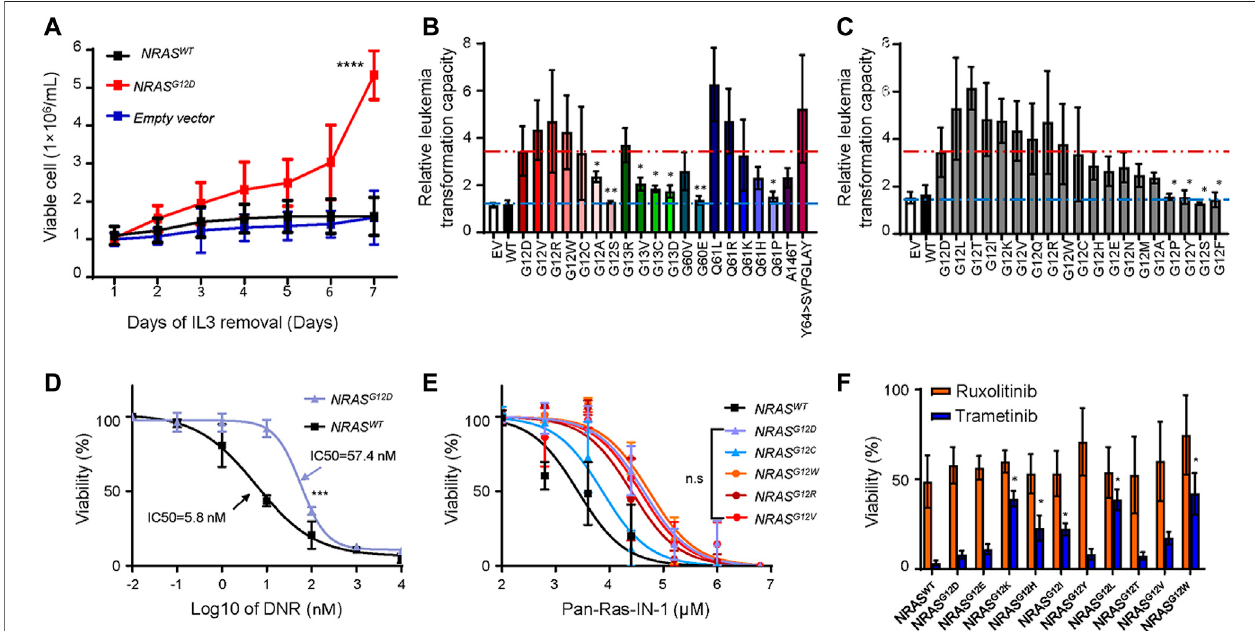
FIGURE 2 | Transforming potentials and drug response of NRAS mutation s in Ba/F3 cell line. (A) IL-3 independent cell growth of Ba/F3 cells transduced with NRAS G12D , NRAS WT and empty vector. (B – C) Relative leukemogenic capacity betweenreportedNRAS mutations (B) and G12saturated mutant forms (C) . Differences were calculated between NRAS G12D and other NRAS mutants by student t test. Dark red dash line represents the NRAS G12D transforming capacity as positive control, and light blue dash line represents non-transforming capacity. The relative capacity was calculated by the ratio of viable cells between day7 and day1. Cytotoxicity of DNR (D) , Pan-Ras-IN-1 (E) , trametinib and ruxolotinib (F) were examined in Ba/F3 cells with NRAS mutations (black line, NRAS WT ; purple line, NRAS G12D ; blue line, NRAS G12C ; orange line, NRAS G12w ; brown line, NRAS G12R ; red line, NRAS G12V ). The cell viability was measured after 72 h of drug exposure using an CCK-8 assay. All theseexperiments were performed in triplicate and independently repeated three times.Two-way ANOVA methodwas used toperformthe statistical analysisfor (D,E) , and student t test was applied for (F) ” . p < 0.05 (*, < 0.05; **, < 0.01; ****, < 0.0001) was considered statistically signi fi cant.